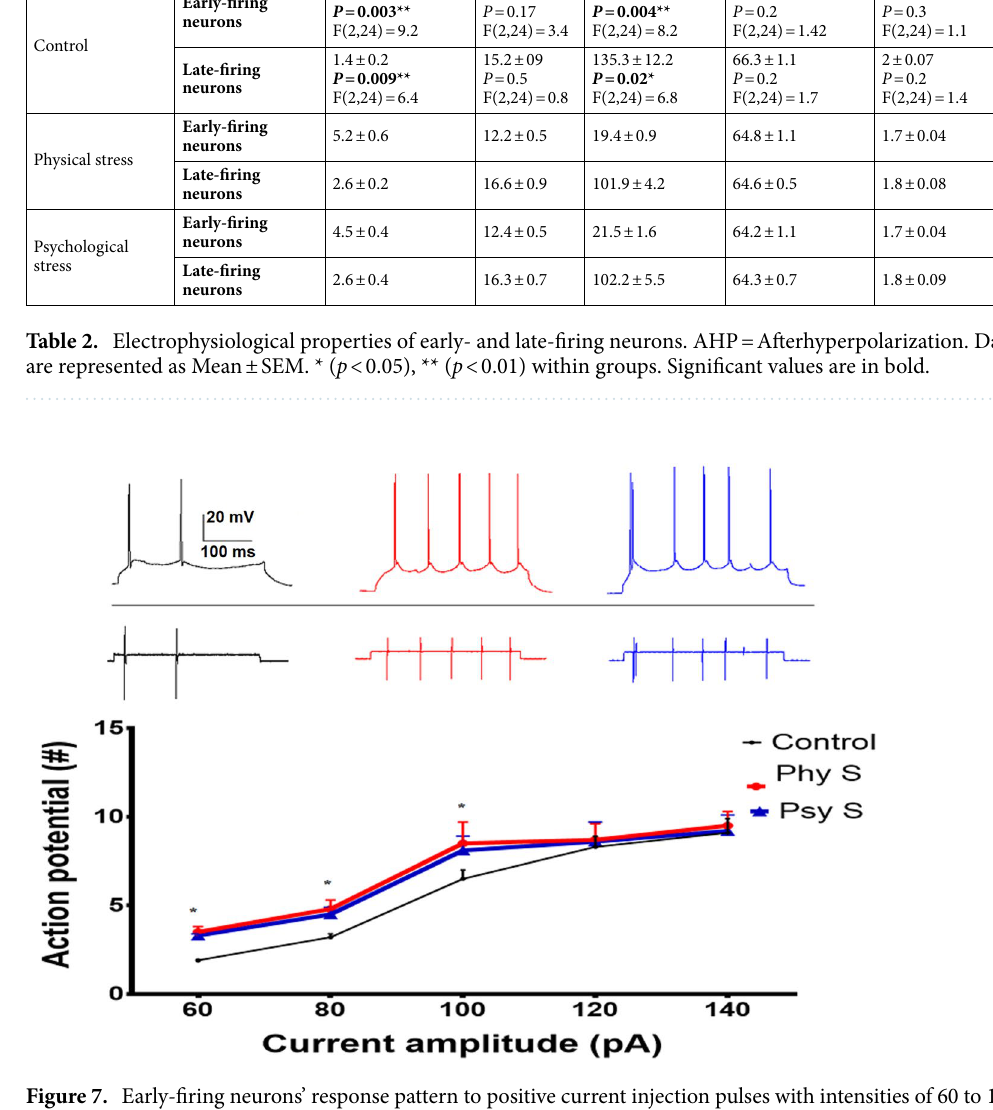
Figure 7. Early-firing neurons’ response pattern to positive current injection pulses with intensities of 60 to 140 pA. Data are represented as Mean ± SEM. * ( p < 0.05) showed a significant difference compared to the control group. Phy S: Physical stress, Psy S: Psychological